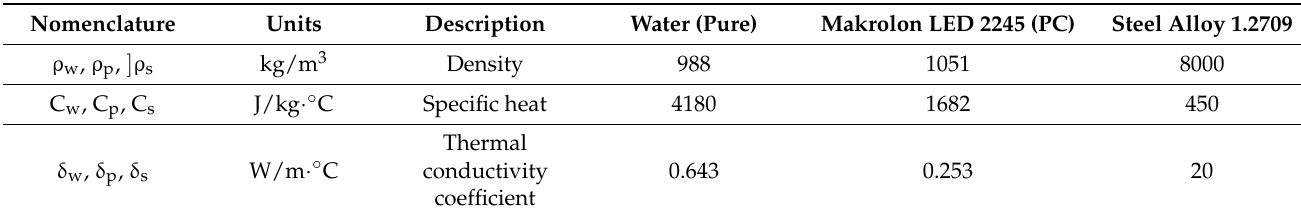
Figure 14. Domains and boundary conditions definition for the numerical simulations, standard cooling solution. Table 5. Magnitude of the physical properties of the defined materials for the numerical